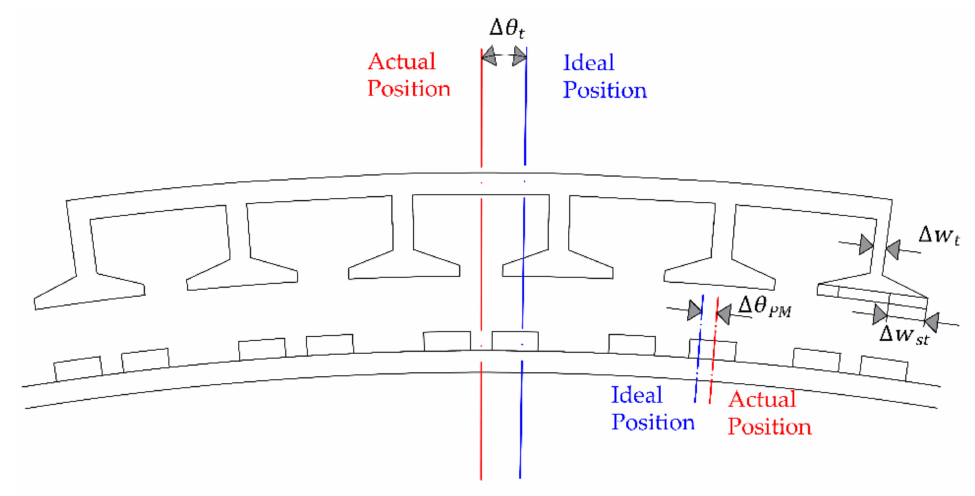
Figure 16. Manufacturing and assembling tolerances considered in the sensitivity analysis.